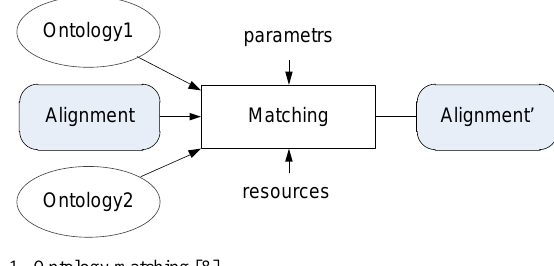
Fig .1. Ontology matching